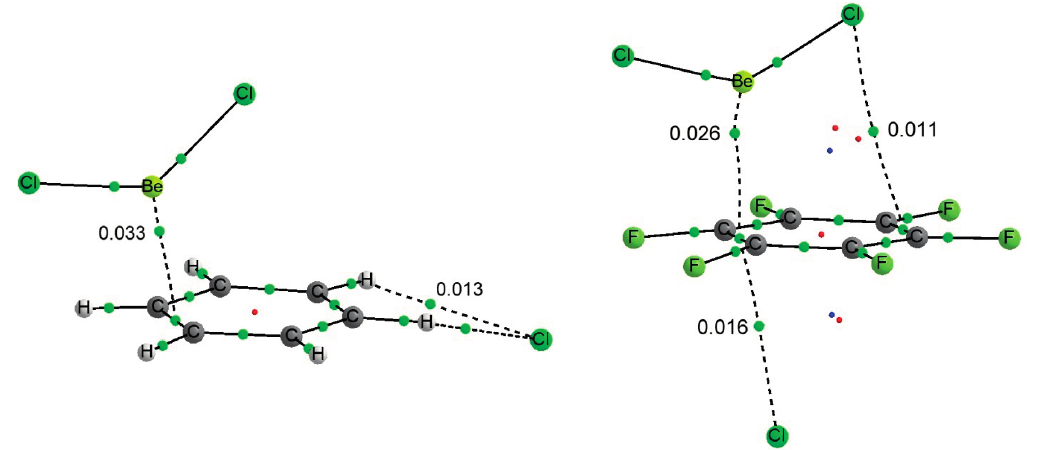
Figure 4. Molecular graph of BeCl 2 :C 6 H 6 :Cl − ( left ) and BeCl 2 :C 6 F 6 :Cl − ( right ). The value of the electron density at the intermolecular BCPs is